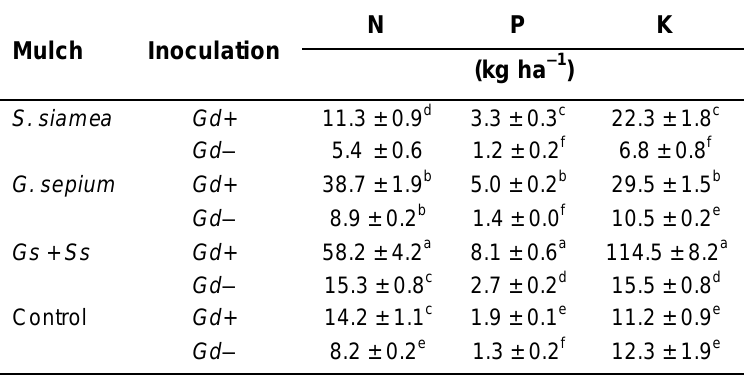
Values are means of three replicates ± S.E. Means in the same column followed by different letters are significantly different at p < 0.05 according to Duncan’s multiple range test. Gs + Ss , Gliricidia sepium and S. siamea mixed mulch; Gd +: Glomus deserticola inoculated; Gd – : G. deserticola uninoculated.